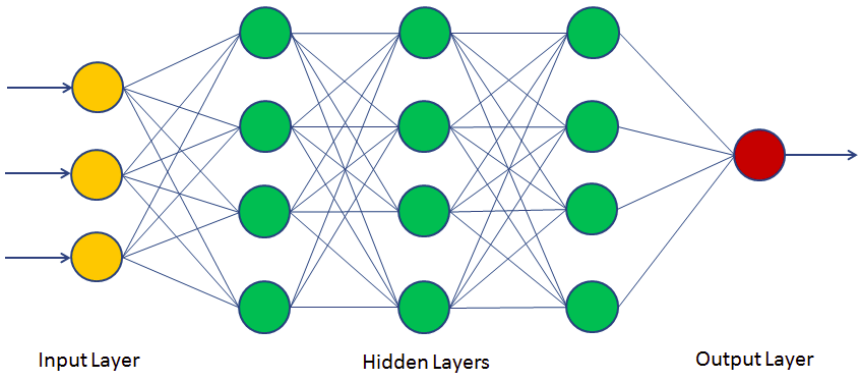
Figure 15. Artificial neural network.